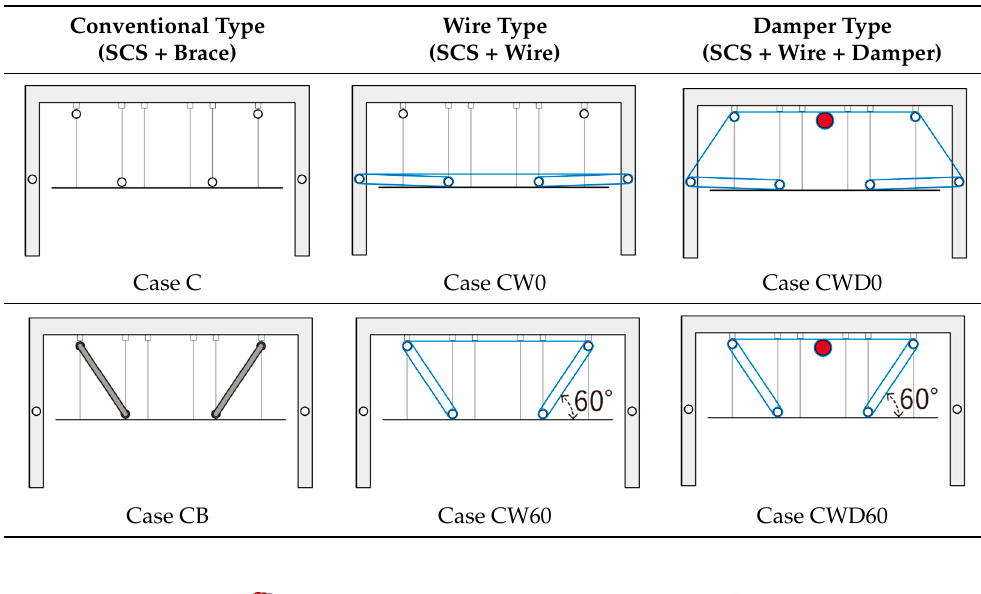
( c ) Figure 12. Schematic view of overall specimen: ( a ) Plan view; ( b ) cross-section view in X-direction; ( c ) cross-section view in Y-direction. 4.2. Test Cases for the Shaking Table Tests In this study, four types of indirect-SCSs with continuous panels were designed to understand the dynamic behavior of the proposed system: conventional SCS (Case C), braced SCS (Case CB), wired SCS (Case CW), and damped SCS (Case CWD), which places the proposed damper in Section 3.1. Moreover, to investigate the influence of the wire